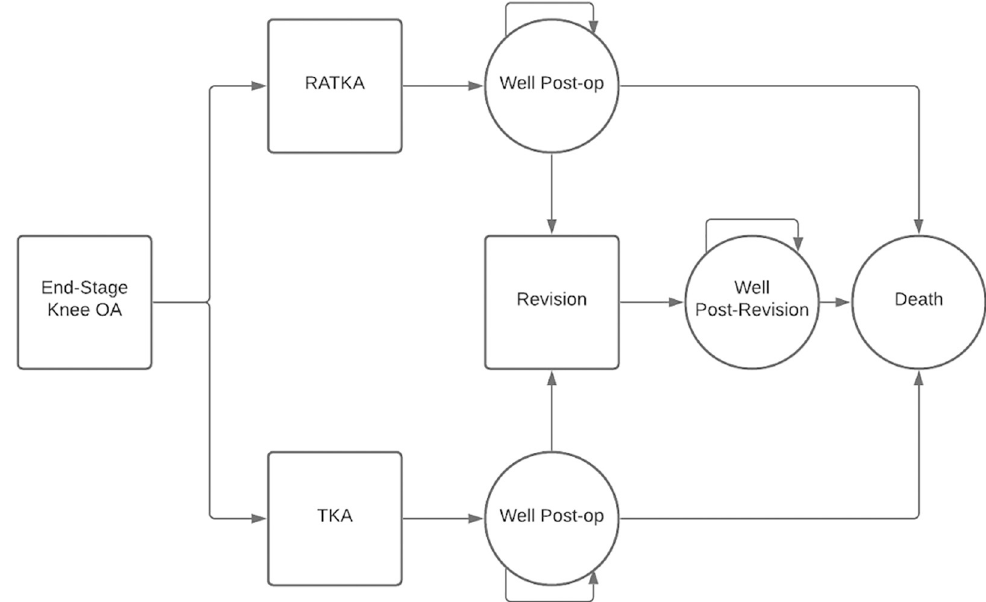
Fig 1. The decision-analytic model. Abbreviations : OA: osteoarthritis; RATKA: robotic-arm assisted total knee arthroplasty.